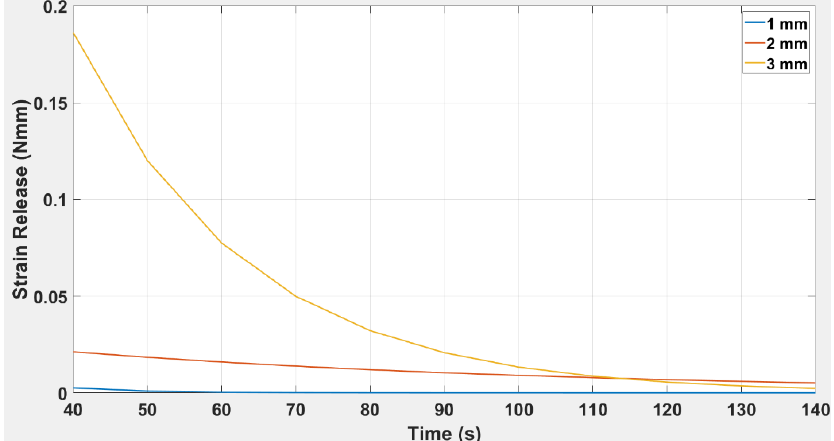
Figure 23. Strain release versus time for TPU inside an embedded DCB beam for thicknesses: 1.0 mm, 2.0 mm, and 3.0 mm.